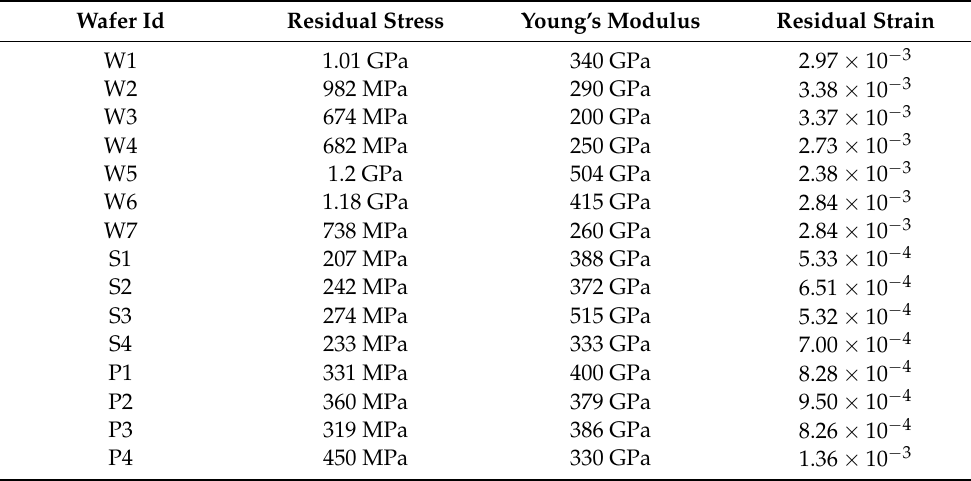
Table 3. Overview of residual stress and Young’s modulus measurements on all the